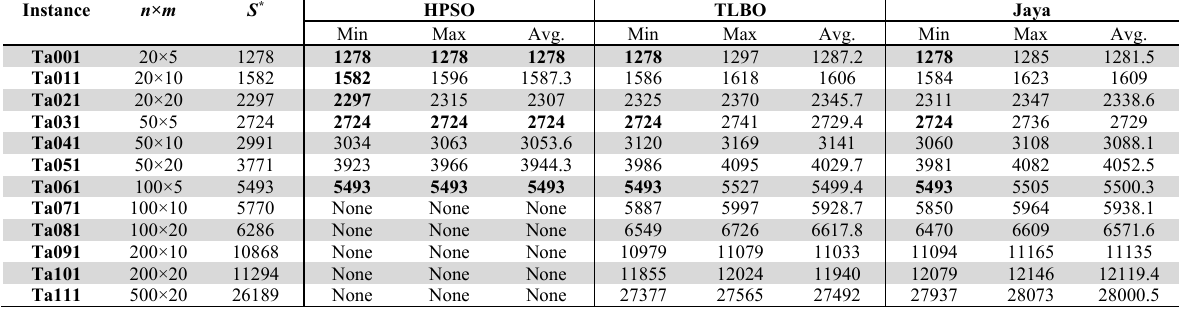
Comparisons of HPSO, TLBO and Jaya. Bold indicate the best solution obtained among various algorithms Instance